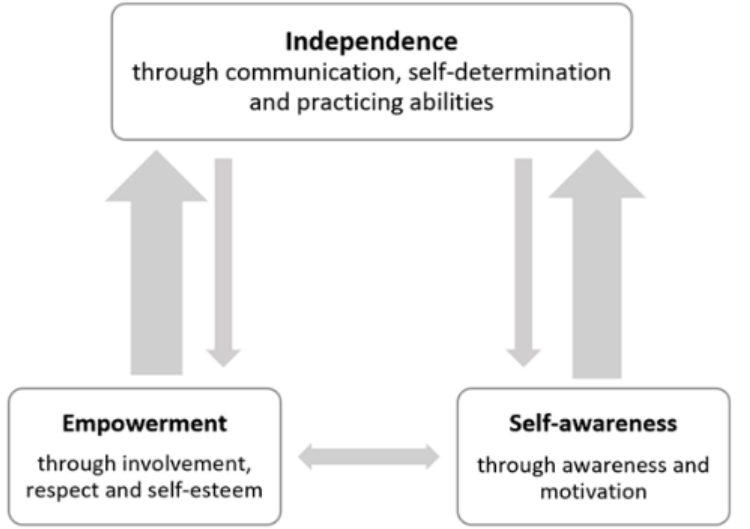
Figure 1. The outcome space—the parents’ collective understanding of the value of children’s participation in pediatric rehabilitation services and the relationship between the categories.